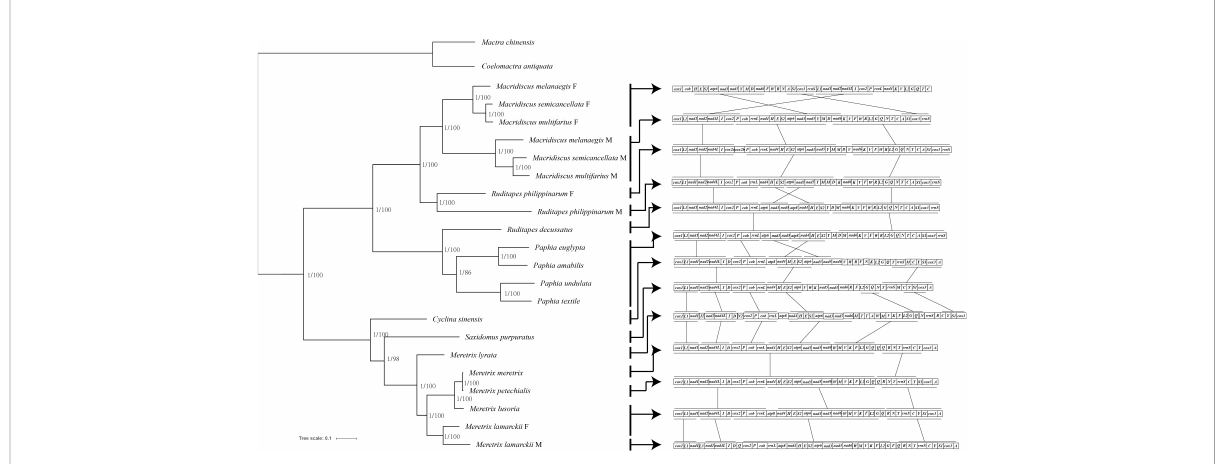
FIGURE 2 Phylogeny of the Family Veneridae based on nucleotide sequences of the 12 PCGs and rearrangement of mtDNA. The topology is ML tree. Numbers in front of the nodes are Bayesian posterior probabilities and back of the nodes are ML bootstrap proportions, right side ligature is conservative gene